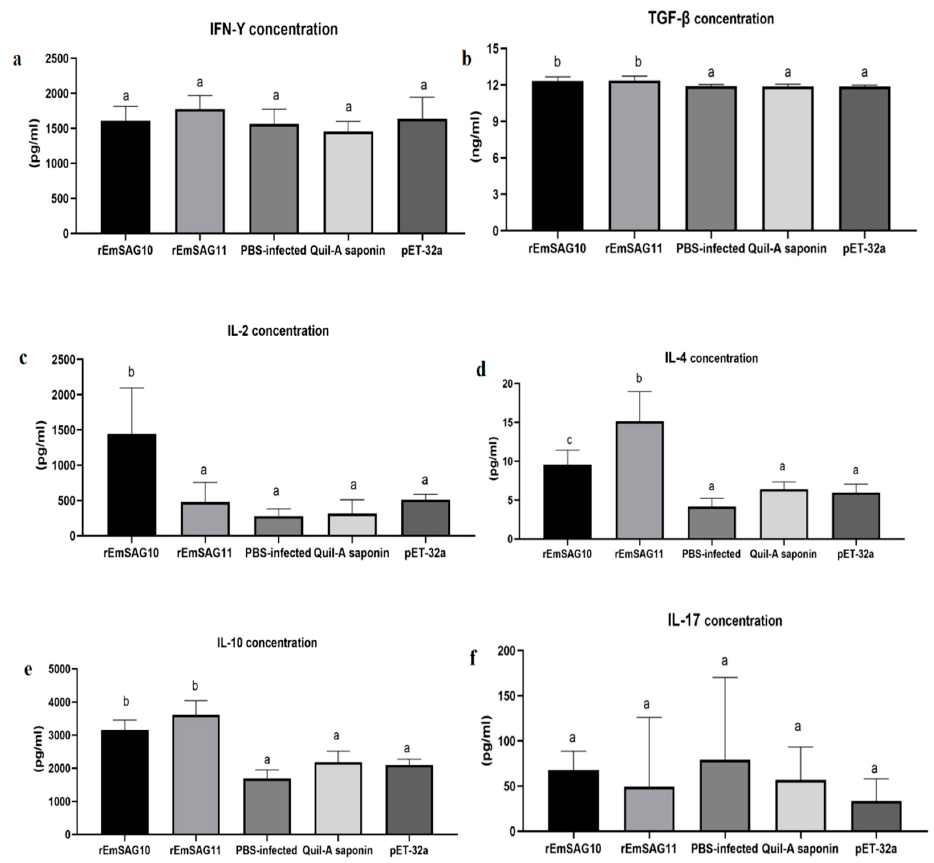
Figure 7. Measurement of the cytokines in the serum of r Em SAG10 and r EmSAG11 before infection. The levels of cytokines IFN- γ ( a ), TGF- β ( b ), IL-2 ( c ), IL-4 ( d ), IL-10 ( e ), and IL-17 ( f ) in the rabbit serum were measured using ELISA. Different superscripts (a, b) indicate a significant difference ( p < 0.05). The same superscript indicates no significant difference ( p > 0.05). The unit of TGF- β concentration was ng/mL, and the unit of other cytokines concentration was pg/mL. All values were estimated by ANOVA (Duncan’s post hoc) at p ≤ 0.05.